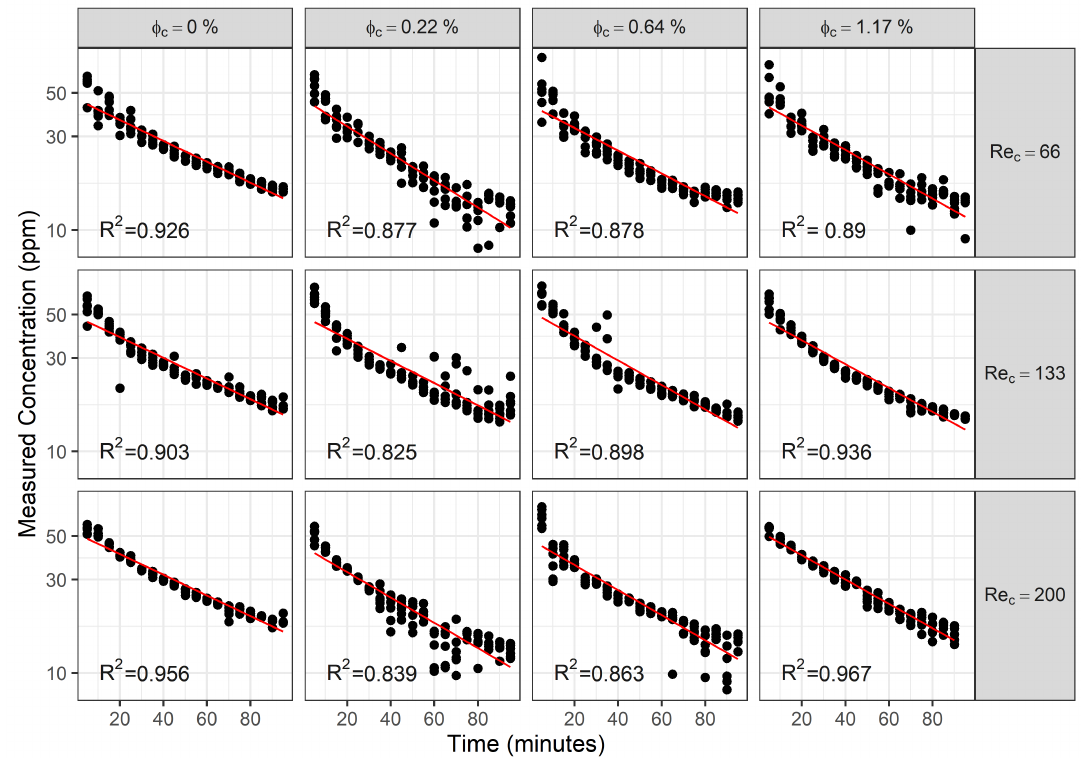
Figure A5. Data from our experimental runs (black points), after outlier removal (See Section 2.1.2), demonstrating the fit of the log-transformed linear model (red lines). Concentrations are presented in volumetric parts per million (µL/L). Plots are arranged according to collector solid volume fraction ( φ c ) and Re c . All runs without biofilm present are